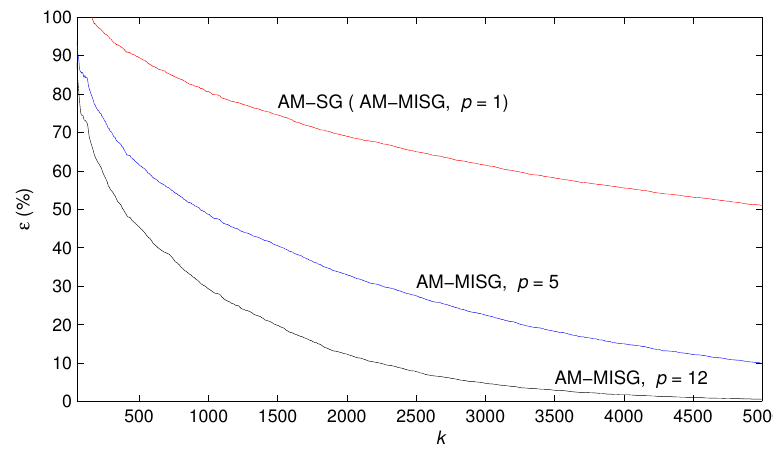
Figure 3. The AM-MISG estimation errors ε versus k with p = 1, 5, 12.